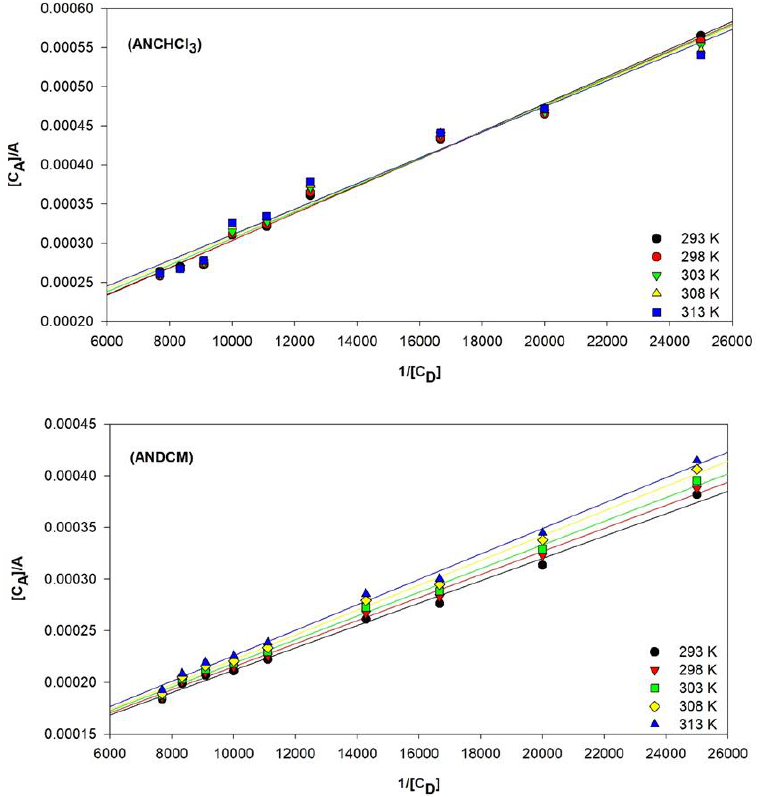
Figure 9. Benesi – Hildebrand plots of AMFP – DDQ CT complex in different solvent systems at dif- ferent temperatures.